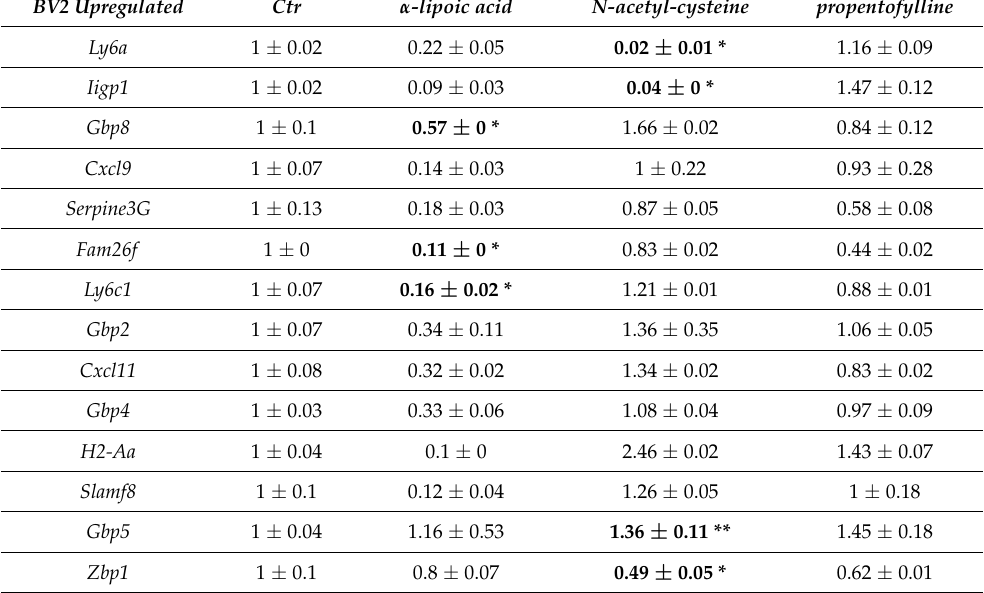
Table 2. Fold change ± SEM of inflammatory marker genes in BV2 compared with non-inflamed cells. The statistically significant differences between treated and untreated control cells are shown by asterisks (* p < 0.05, ** p < 0.01) and bold